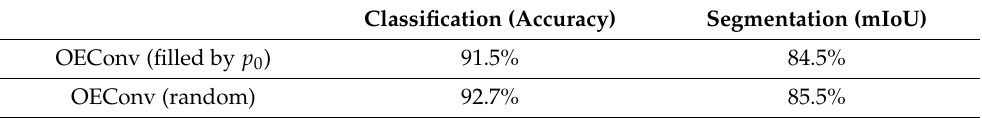
Table 3. The selection of points in